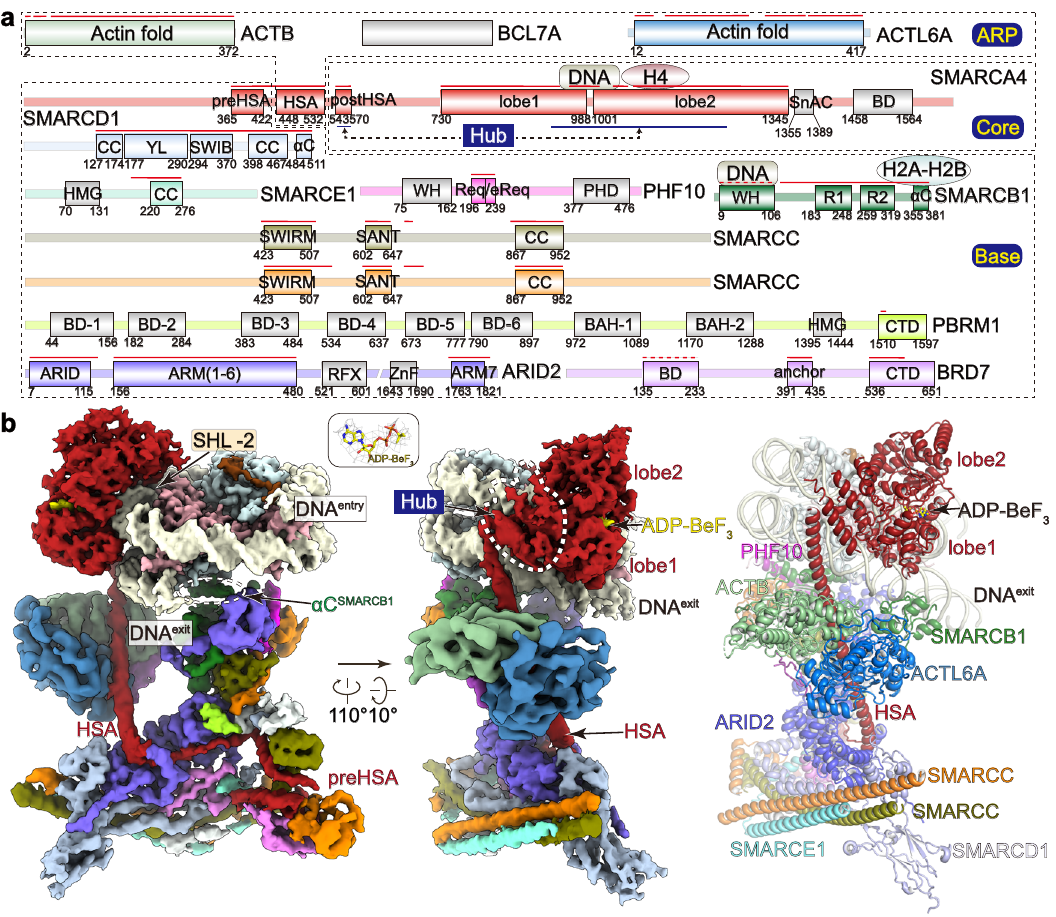
Fig. 1 |Cryo-EMstructureofthenucleosome-bound PBAF.a Schematicdiagram of the 13-subunit PBAF complex organized into the Base, ARP, and Core modules. Domainsareshownwithboundariesindicatedwithnumbers.Histone/DNA-binding domainsofindicatedsubunitsareshown.Colorschemeisusedthroughout fi gures